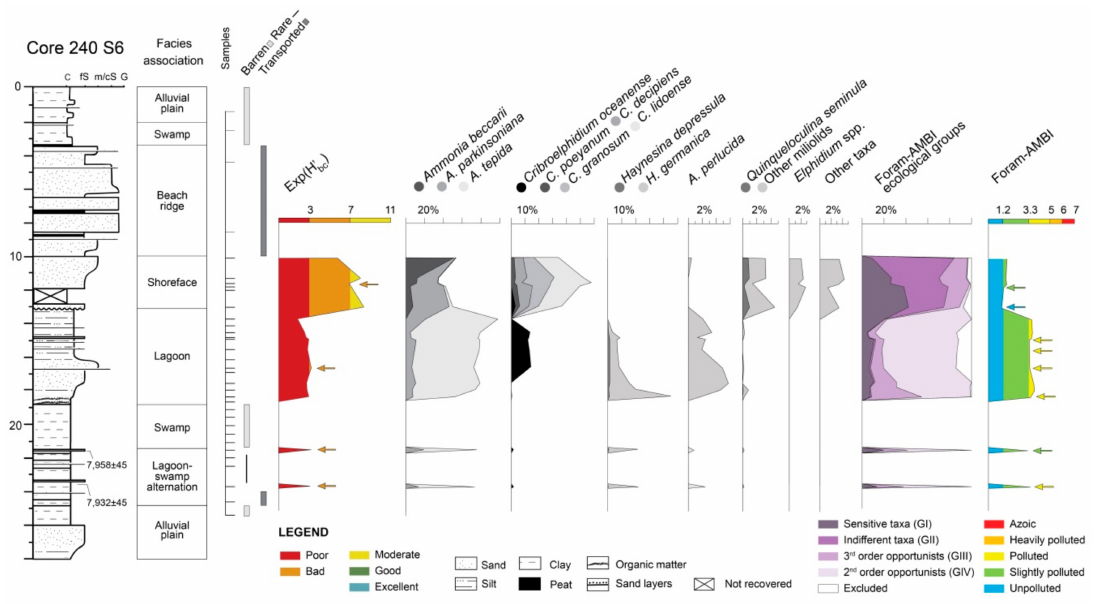
Figure 4. Stratigraphy, vertical distribution of benthic foraminifer taxa, exp(H’ bc ), and related PaleoEcoQs, Foram − AMBI ecological groups, and Foram − AMBI values of core 240 S6. Ages are reported as calibrated years BP. Samples barren in benthic foraminifers, including rare or transported tests are evidenced. Arrows are colored according to sample classification to improve the graphical visibility of selected